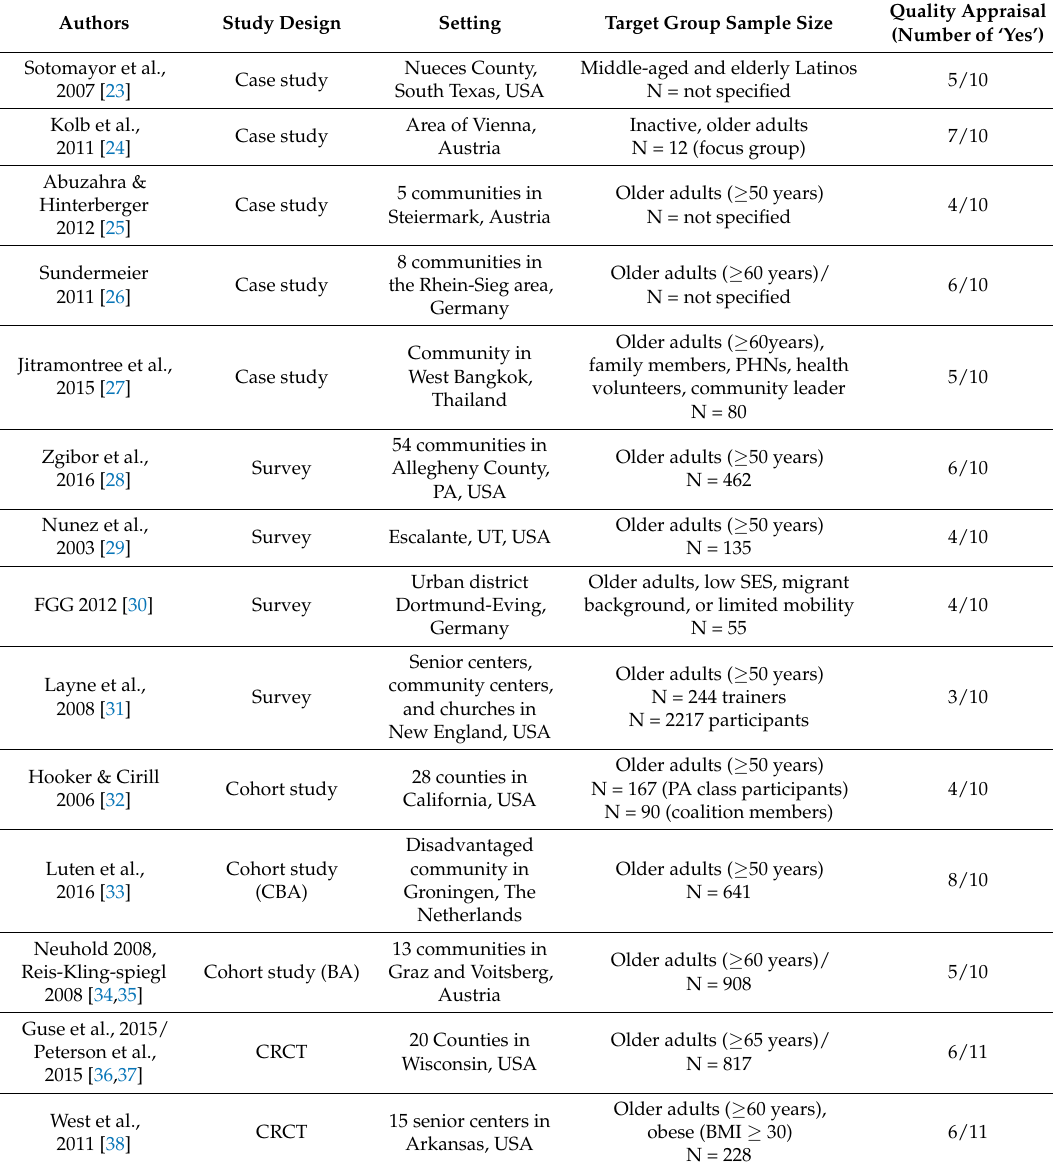
Table 1. Characteristics of the included